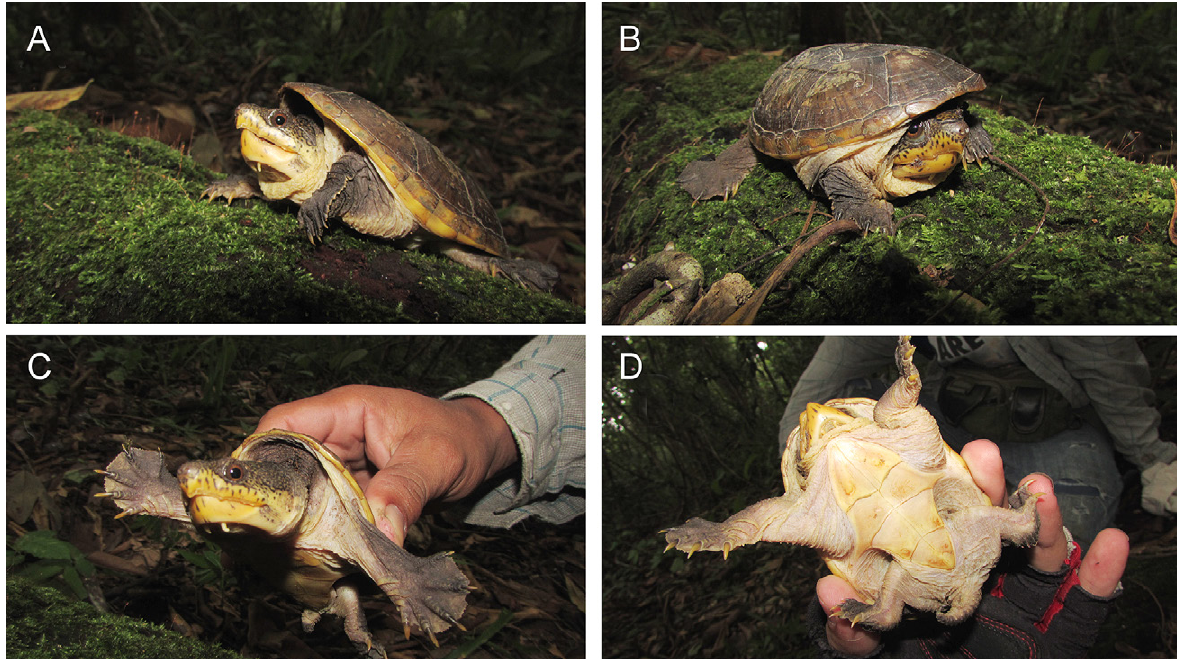
Figure 2. Claudius angustatus. A. Dorsal view of the body. B. Frontal view of body. C. View of the head and webbed feet. D. Ventral view of the